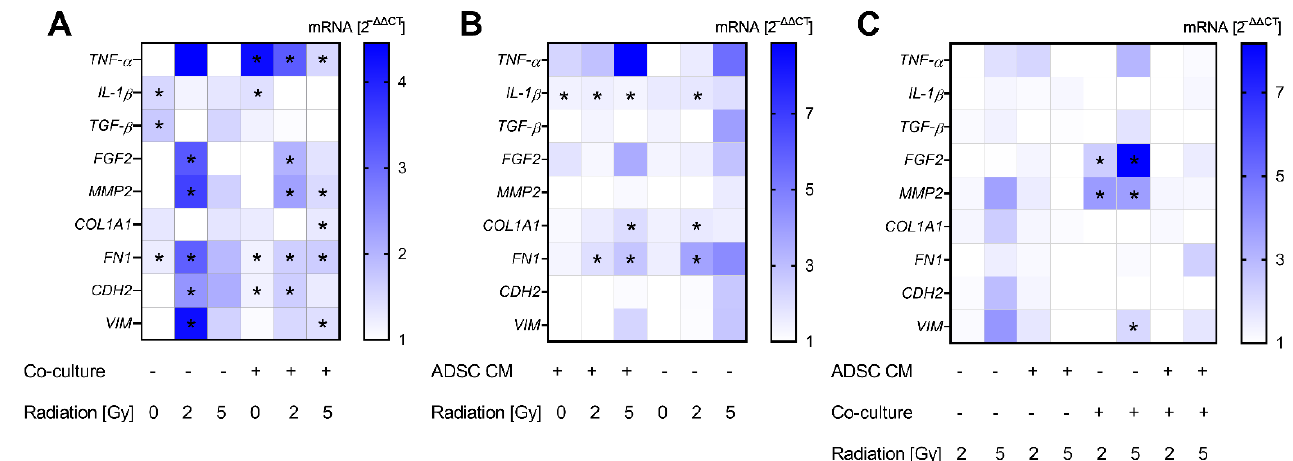
Figure 4. Alterations in gene expression profiles at the mRNA level in MCF-10A cells. The heatmaps show mean relative mRNA expression in MCF-10A cells compared to GAPDH/YWHAZ and to the corresponding control group, n = 3 replicate experiments. ( A ) Shows the effect of treatment with conditioned medium (CM) of adipose-derived stem cells (ADSC) normalized to treatment with control CM. ( B ) Presents the effect of co-cultivation with fibroblasts normalized to monocultures. The effect of irradiation is demonstrated in ( C ), whereby irradiation with 2 Gy and 5 Gy is normalized to 0 Gy. Values were calculated using the 2 −ΔΔCT method, 2 −ΔΔCT of control = 1. White fields: 2 −ΔΔCT < 1; * p < 0.05, increased compared to the corresponding control (Mann – Whitney U-test). TNF- α : tu-